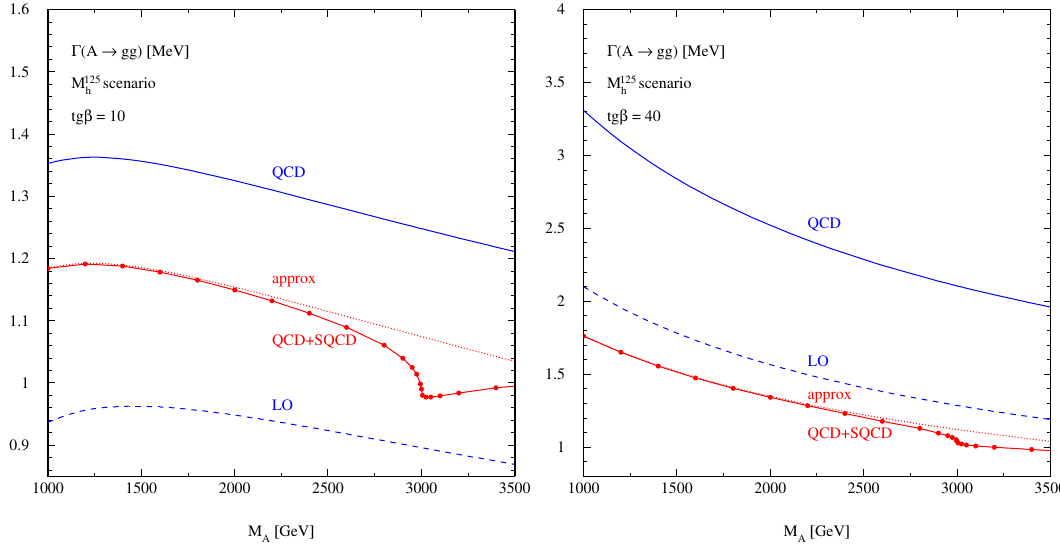
Figure 12 . Partial decay widths Γ( A → gg ) as a function of the pseudoscalar mass M A for tg β = 10 (left) and tg β = 40 (right) at NLO QCD and including the genuine SUSY-QCD corrections involving effective Yukawa couplings. The renormalization scale has been chosen as µ R = M A